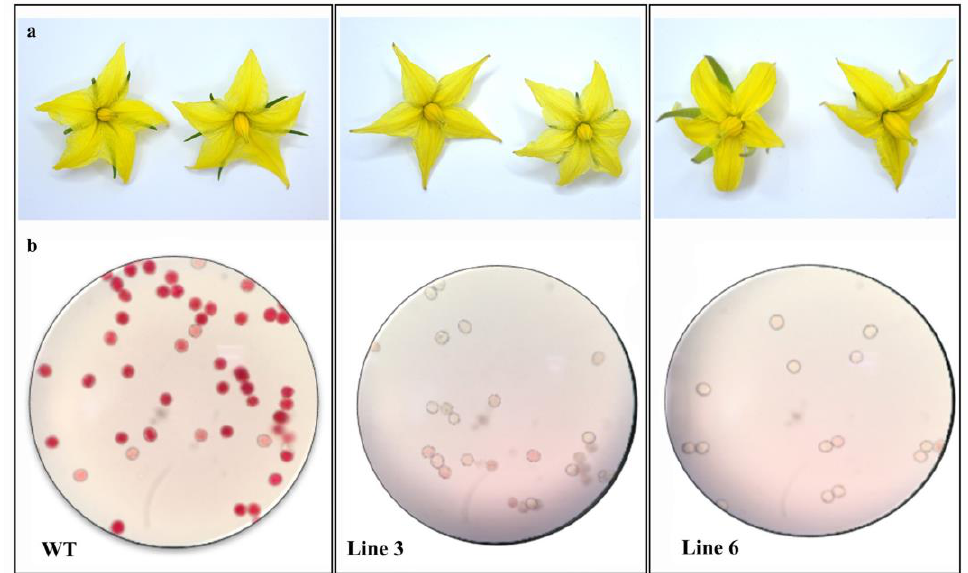
Figure 4 . Morphological comparisons of WT and SlACO2 mutant plants. ( a ) Flower structures of WT and SlACO2 mutant plants. ( b ) Light microscopy photos of pollen viability in WT and mutant plants (Line 3 and Line 6) obtained by TTC test.